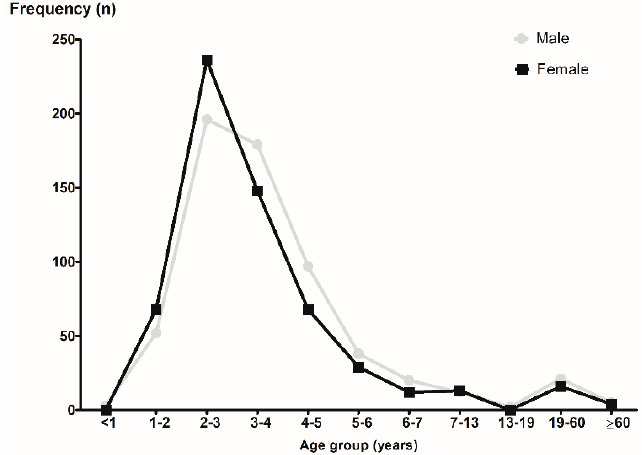
Figure 1. The frequencies of nasal foreign body according to the age group and sex.